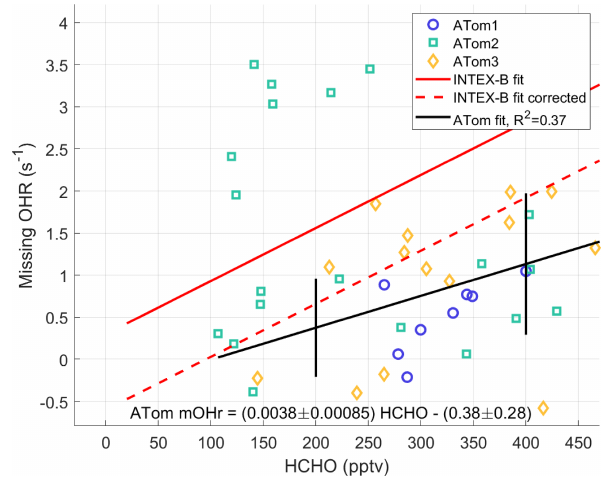
Figure 9. The best correlations with missing OH reactivity for data at the per-flight resolution across all latitudes and hemispheres. The symbols are per-flight data for ATom1 (circles), ATom2 (squares), and ATom3 (diamonds). Black lines are least-squares fits to the per- flight data (units are ppbv for butanal and DMS, pptv for HCHO, and ◦ C for SST).